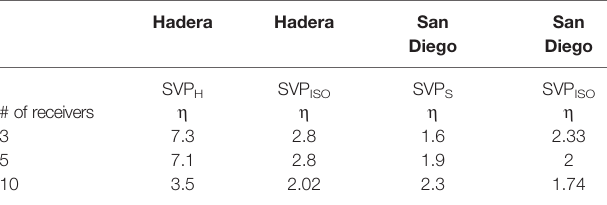
TABLE 3 | h - from (17) for deployment of 3, 5 and 10 receivers at the Hadera power station and in San Diego. Hadera Hadera San